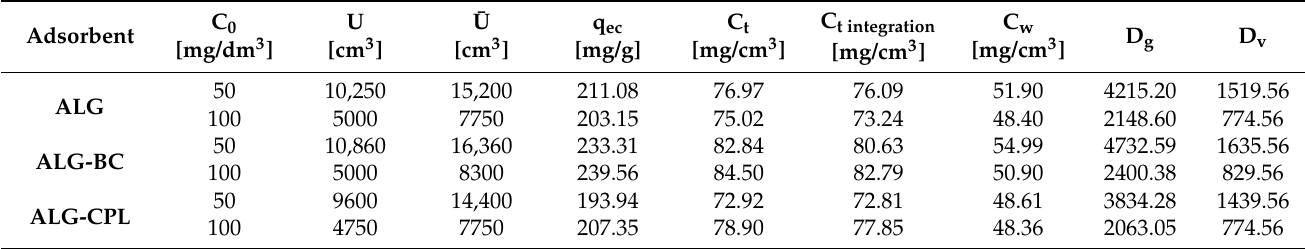
Table 2. Dynamic studies parameters of La(III) ions adsorption onto the alginate-based adsorbents (pH = 5.00 ±